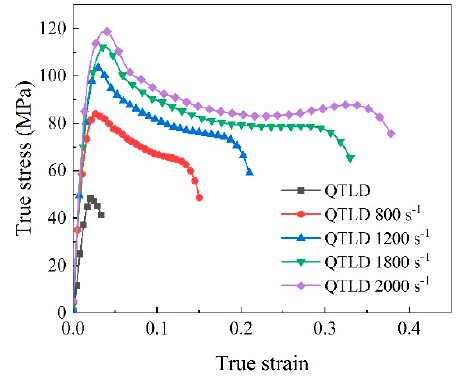
Figure 8. Typical stress–strain curves of beech specimens at different rates in DTLD.